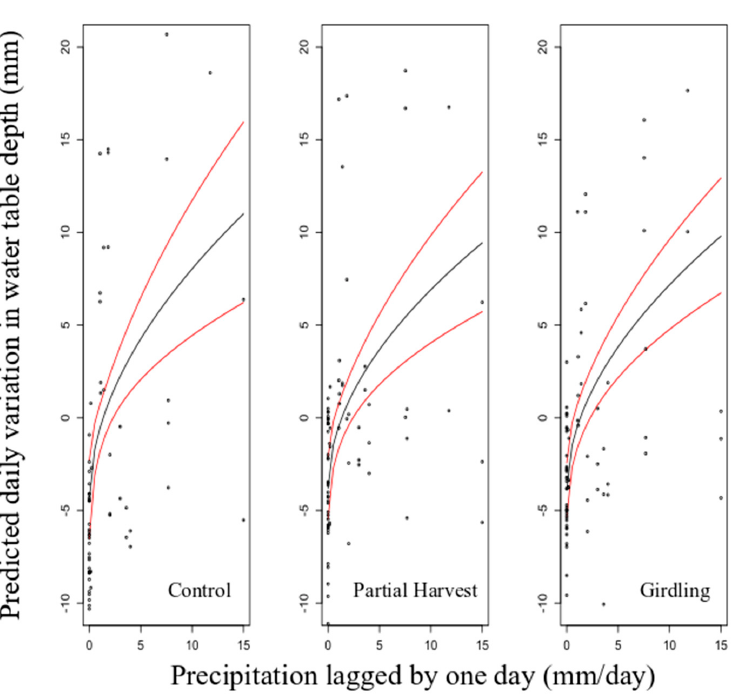
Figure 3. Predicted daily variation in water table depth before treatments based upon precipitation lagged by one day (mm/day) interacting with silvicultural treatment (Control, Partial harvest and Girdling). Model-averaged predictions using the entire set of candidate models are included with 95% CI. Open circles correspond to the original observations. Note that in this figure, daily variation in water table depth was back-transformed from square-root values. The figure shows the effect of variables having the greatest influence on the response variable.